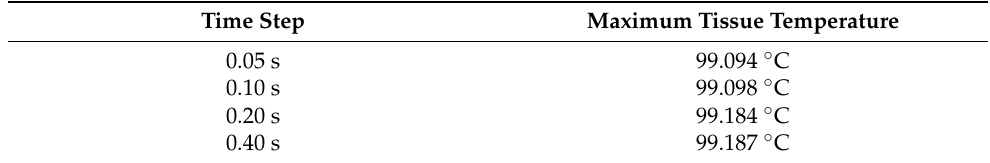
Table 4. Maximum tissue temperatures evaluated for different maximum time steps